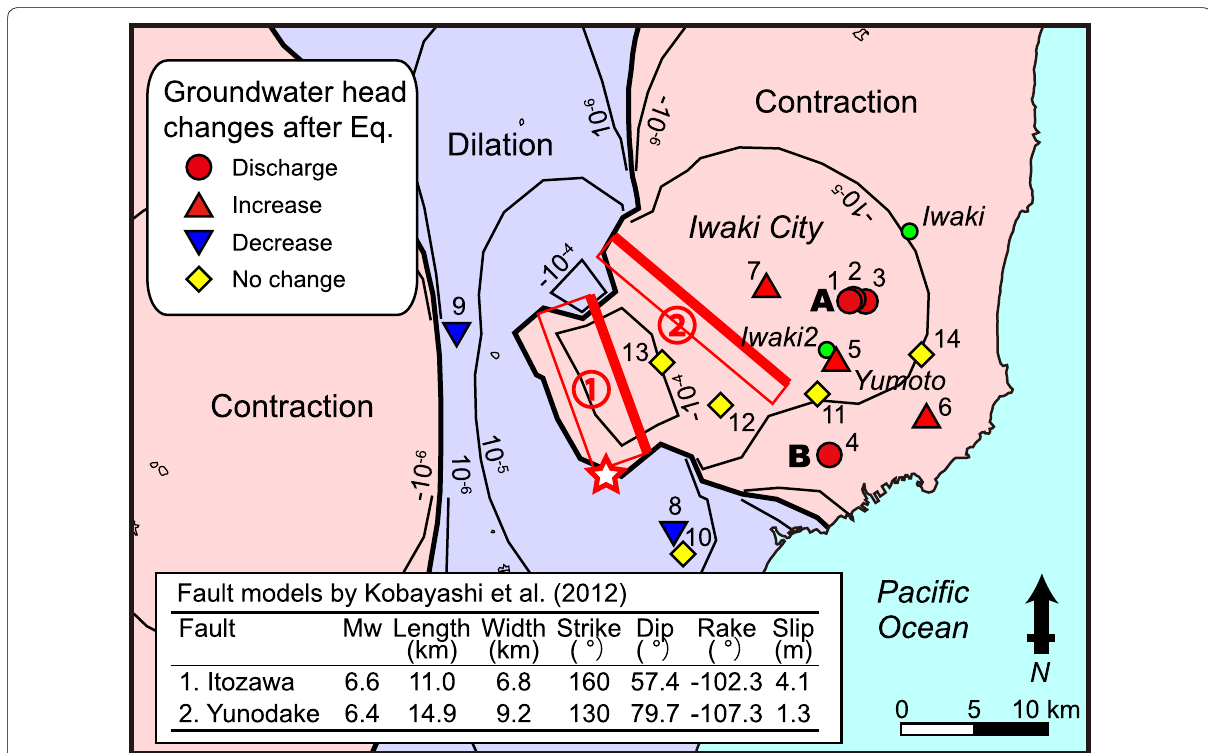
Fig. 2 Spatial distribution of coseismic changes in the groundwater head due to 2011 Iwaki earthquake based on field survey. Red circles, red triangles and blue triangles indicate hot springs where discharge, water level increase, and water level decrease were observed during earthquake, respectively, and numbers correspond to those in Table 1. Calculated results of the changes in the crustal volumetric strain during earthquake using fault models proposed in Kobayashi et al. (2012) are also